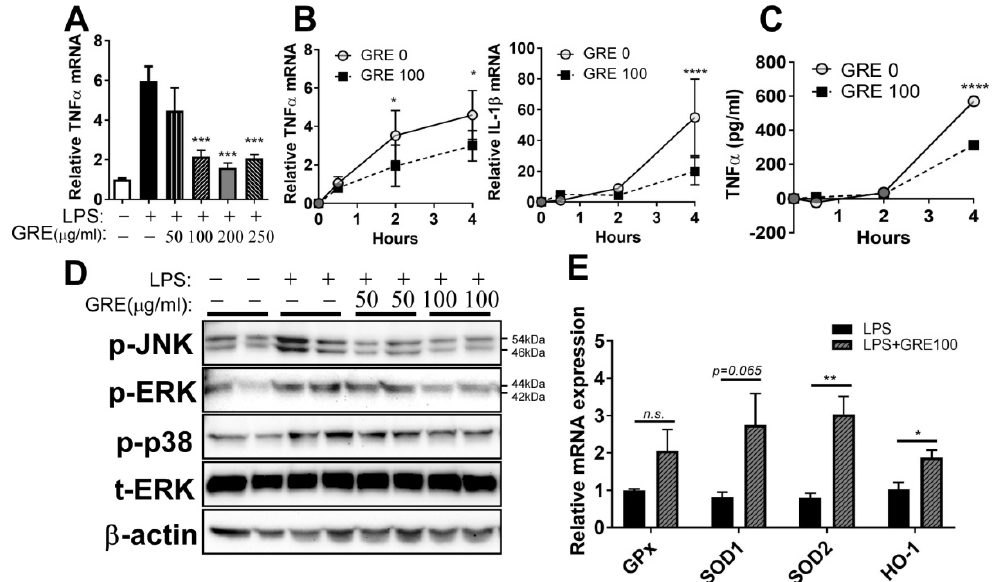
Figure 3. GR extract attenuated LPS-induced inflammatory responses and ER stress with the induction of antioxidant gene expression in mouse bone-marrow-derived macrophages (BMDMs). BMDMs were pretreated with GRE (50–250 µ g / mL) for 48 h in FBS-containing completed media and then starved in DMEM for 12–18 h, followed by LPS stimulation (100 ng / mL) for 2 h (A,D) or 0.5, 2, and 4 h (B,C), in the presence or absence of GRE. ( A ) TNF α gene expression by qPCR. ( B ) TNF α and IL-1 β gene expression by qPCR. ( C ) TNF α cytokine production by ELISA. ( D ) Protein extracts from LPS-treated BMDMs were immunoblotted with antibodies targeting p-JNK, p-ERK, p-p38, t-ERK, or β -actin (loading control); BMDMs were pretreated with GRE (100 µ g / mL) for 48 h in FBS-containing completed media and then starved in DMEM, followed by LPS stimulation (100 ng / mL) for 4 h in the presence or absence of GRE. ( E ) GPx, SOD1, SOD2, and HO-1 gene expression by qPCR. All values are presented as the mean ± SEM ( n = 3–4 / group for each experiment). * p < 0.05; ** p < 0.01; *** p < 0.001; **** p < 0.0001; compared with LPS-treated group vs. LPS + GRE-treated group by one-way ANOVA with Bonferroni’s comparison test. + , treatment; − , non-treatment.